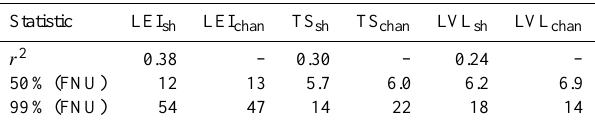
Figure 9. Relationship between wave–current combined shear stress and turbidity at three shoal sites; darker symbols are instan- taneous data binned and averaged in 0.01Pa intervals. Site LEI sh demonstrates enhanced resuspension as compared to other sites un- der similar stress conditions; surficial sediment distribution indi- cates a higher abundance of fine material in the southern part of the system. Table 5. Statistics and correlation of turbidity between channel and shoal at three